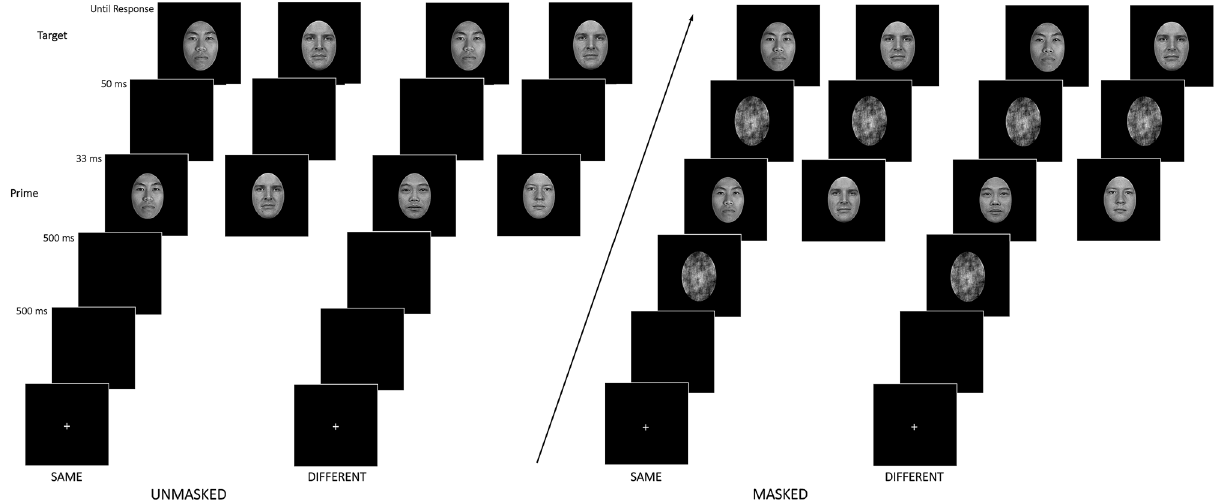
Figure 6. Schematic depiction of the unmasked and masked procedures used in the present